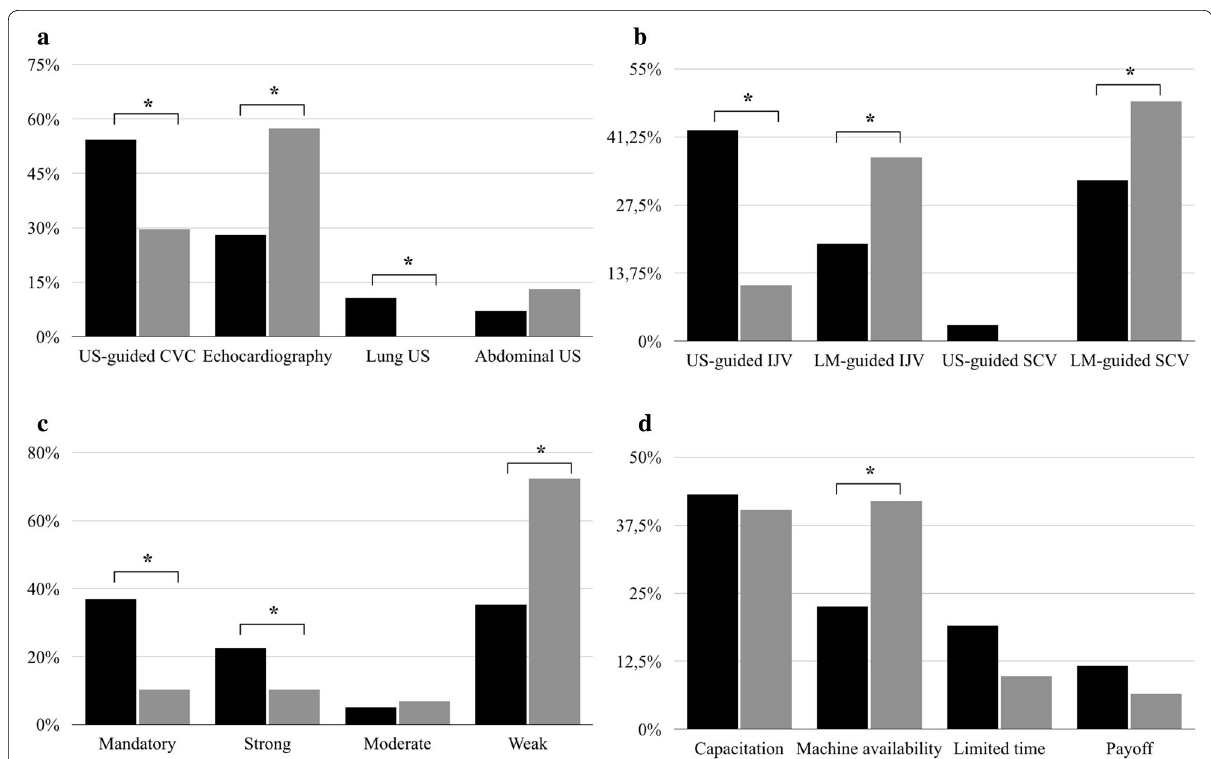
Fig. 1 Black bars represent trained units; gray bars represent non-trained units. a main types of POCUS application; b preferential venous access site; c perceived strength of recommendation for US-guided jugular vein catheterization; and d main barriers for ultrasound dissemination. See text for full explanation. *differences in prevalences with p < 0.05. US ultrasound, CVC central vein catheterization, IJV internal jugular vein, SCV subclavian vein, LM